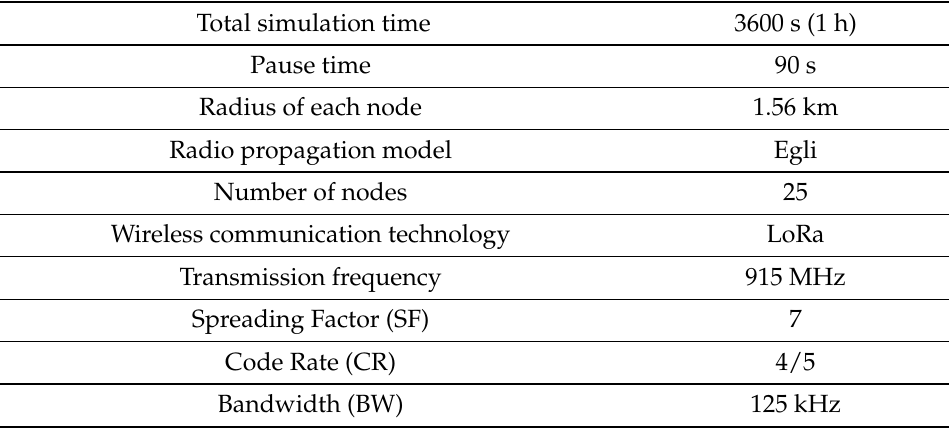
Table 1. General parameters used in the